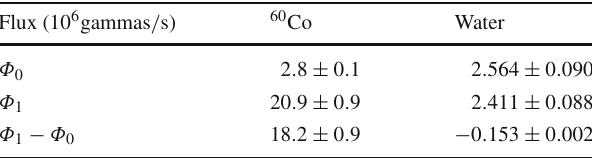
Table 5 Total gamma fluxes through the interior of the MS as deter- minedfromsimulations. Φ 0 iseitherthefluxwiththeclosed 60 Cosource (second column) or with no water shielding (third column). Similarly, Φ 60 Co source or with water shield- 1 is either the flux with the open ing. The flux includes all crossings (ingoing and outgoing) of the inner surface. The errors include both statistical and systematic uncertain- ties, although the latter only includes the uncertainty on the activity of the gamma sources (see Table 1). Other systematic effects, such as the accuracy of the included Geant4 physics processes and the correctness